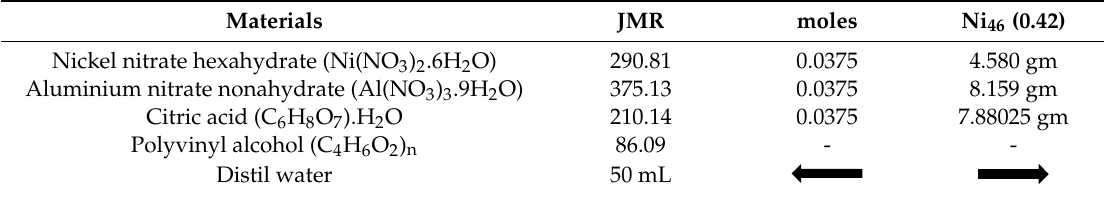
Table 2. JMR information of the raw material.